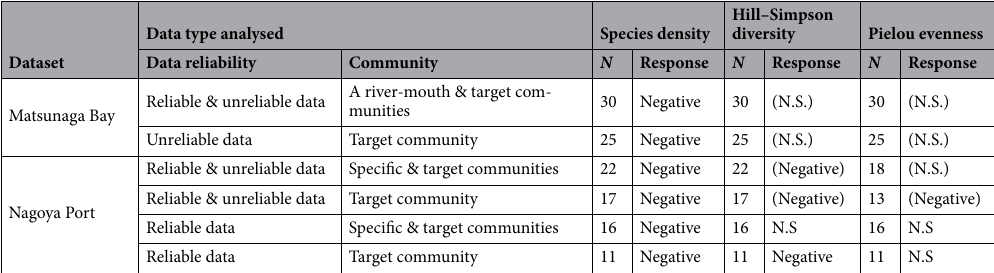
Table 2. Summary of generalised linear model results for two local datasets: Matsunaga Bay and Nagoya Port. Shown are the responses of diversity indices to sediment water content. N.S. means that the response was not significant. Results in parentheses are questionable because they are based on unreliable data (fewer than 50 individuals